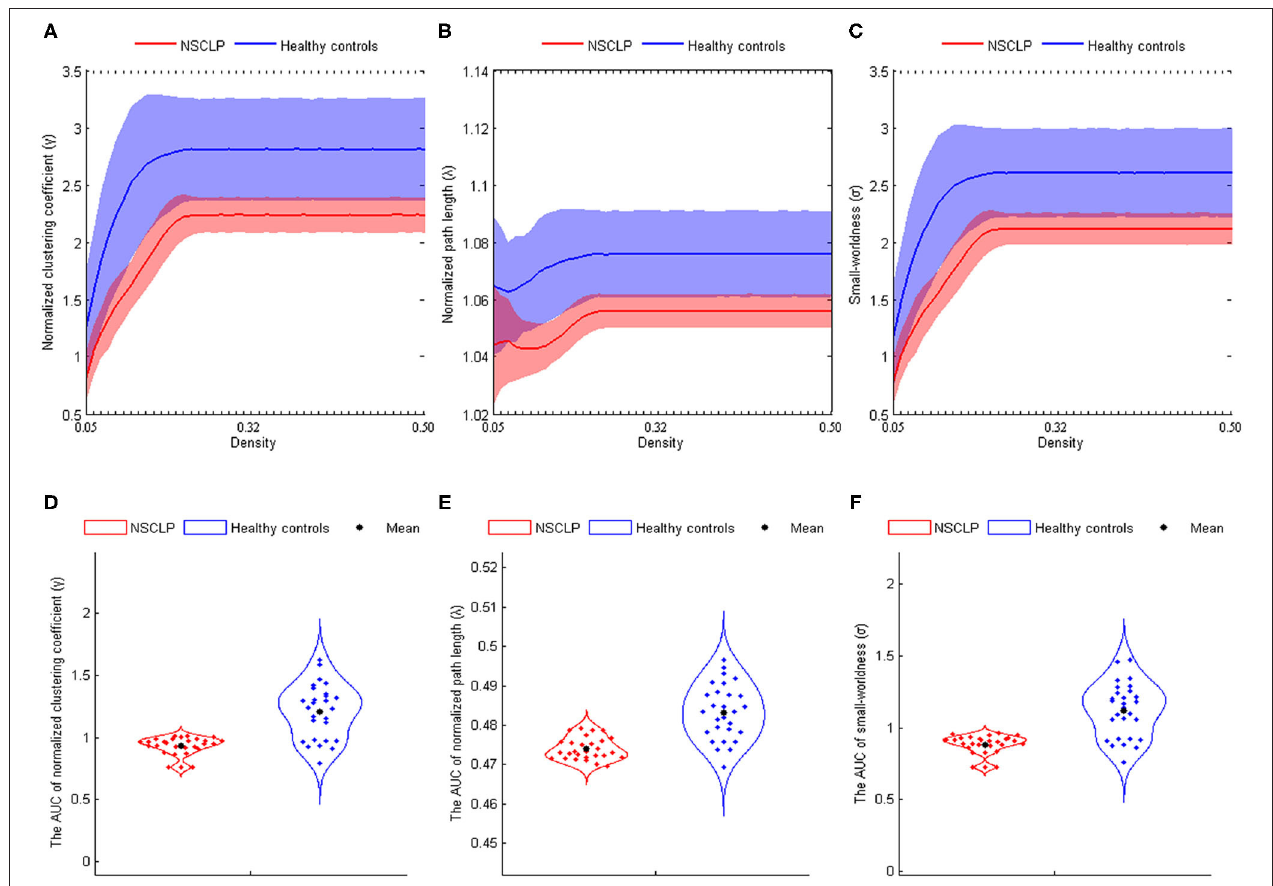
FIGURE 2 | (A–C) The normalized clustering coefficient (A) , normalized path length (B) , and small-world index (C) shown at the whole threshold. Shaded areas represent the standard deviation of the mean. (D–F) : Significant differences in the normalized clustering coefficient (D) , normalized path length (E) , and small-world index (F) . Corrected for age and gender. Two-sample two-tailed t -test, p < 0.05. AUC, area under the curve; NSCLP, non-syndromic cleft lip and palate; HC, healthy